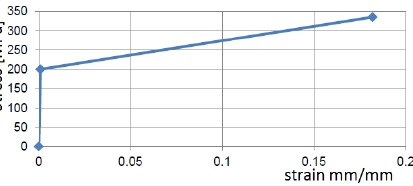
Fig.15 Bilinear material